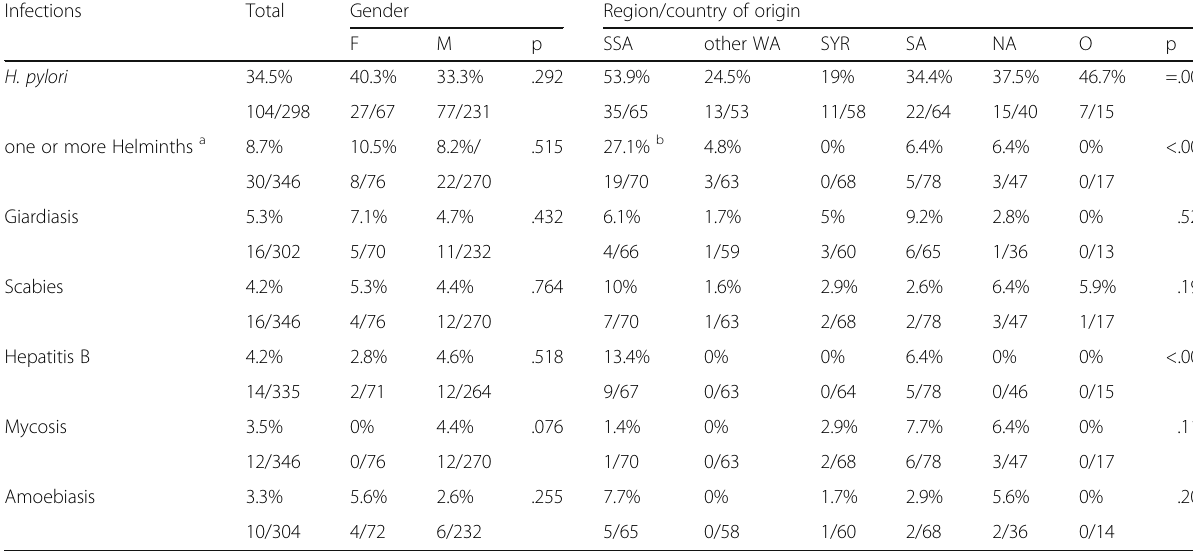
Table 4 Prevalences (%) of the most common infections Infections Total Gender Region/country of